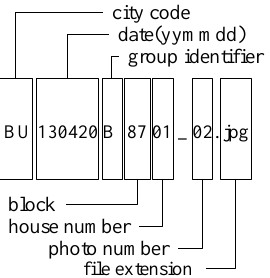
Figure 9. File protocol. © UNESCO Field survey project